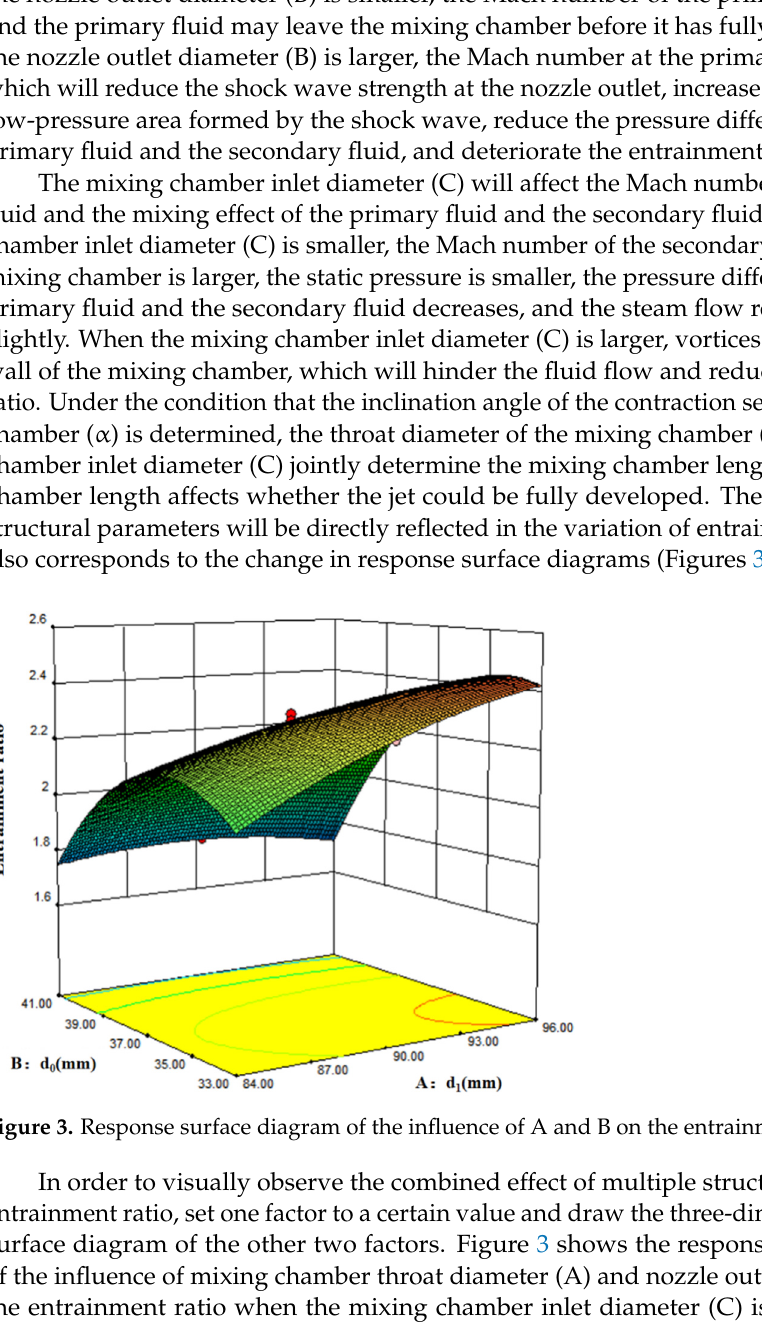
Table 7. Variance analysis of response surface quadratic model of the ejector.